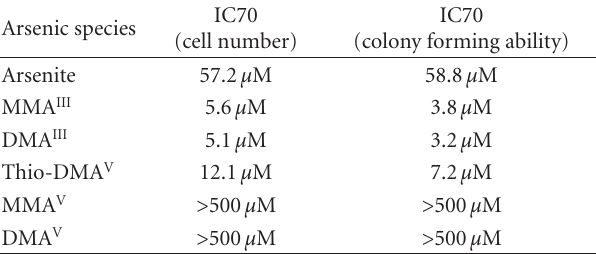
Table 1: Cytotoxic e ff ects of the arsenicals in A549 cells after 24 h incubation. Shown are IC70 values for the endpoints cell number and colony forming ability. In case of arsenite, MMA III , DMA III , MMA V , and DMA V IC70 values were generated from the data originally published in Ebert et al. 2011 [31]; IC70 values represent the respective inhibitory concentrations of the compounds that are required for 30% reduction of cell number or colony forming ability in vitro